Question: What does this figure show? Answer in one sentence.
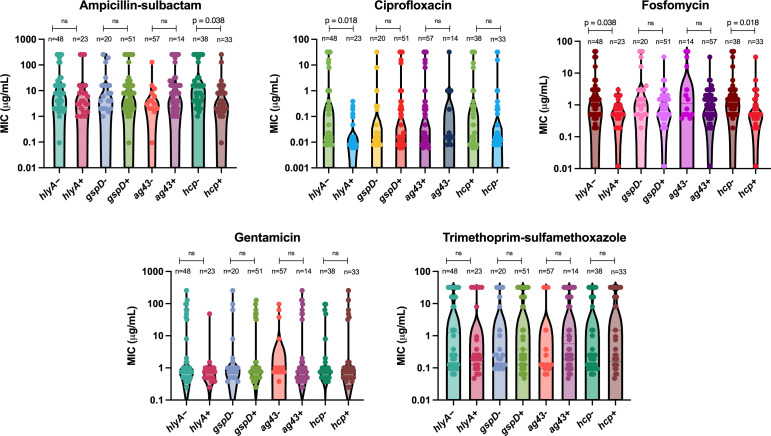
Answer: Secretion-system markers associate with MIC distributions for tested antibiotics. Violin plots show MIC (µg/mL) distributions for clinical UPEC isolates grouped by carriage of each specific secretion-system marker gene: hlyA , gspD , ag43 , and hcp . Each dot represents a single isolate; central lines indicate the median and interquartile range, and n stands for the number of isolates. Pairwise comparisons were performed using Mann-Whitney U tests with Benjamini-Hochberg FDR correction. Adjusted P values are shown on the graph for statistically significant comparisons; ns indicates non-significant comparisons.